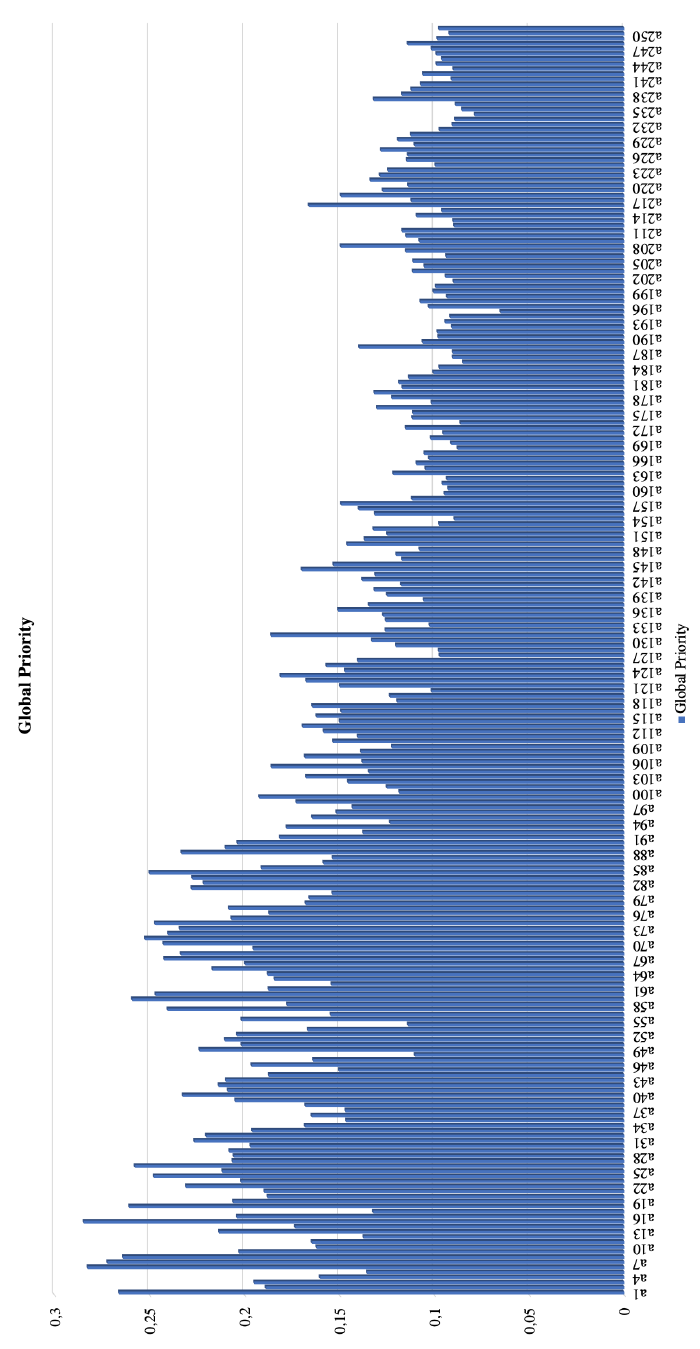
Figure 2: Ranking of school defined by p